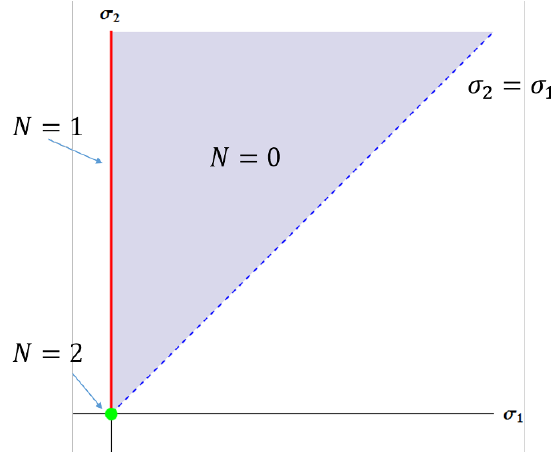
Figure 1 . ( (cid:27) 1 - (cid:27) 2 ) plane. The N = 2 preserving vacuum is located at the origin, and N = 1 preserving (or partially broken) vacuum is on the line (cid:27) 1 = 0 with (cid:27) 2 6 = 0. The other region corresponds to the N = 0 (fully broken)